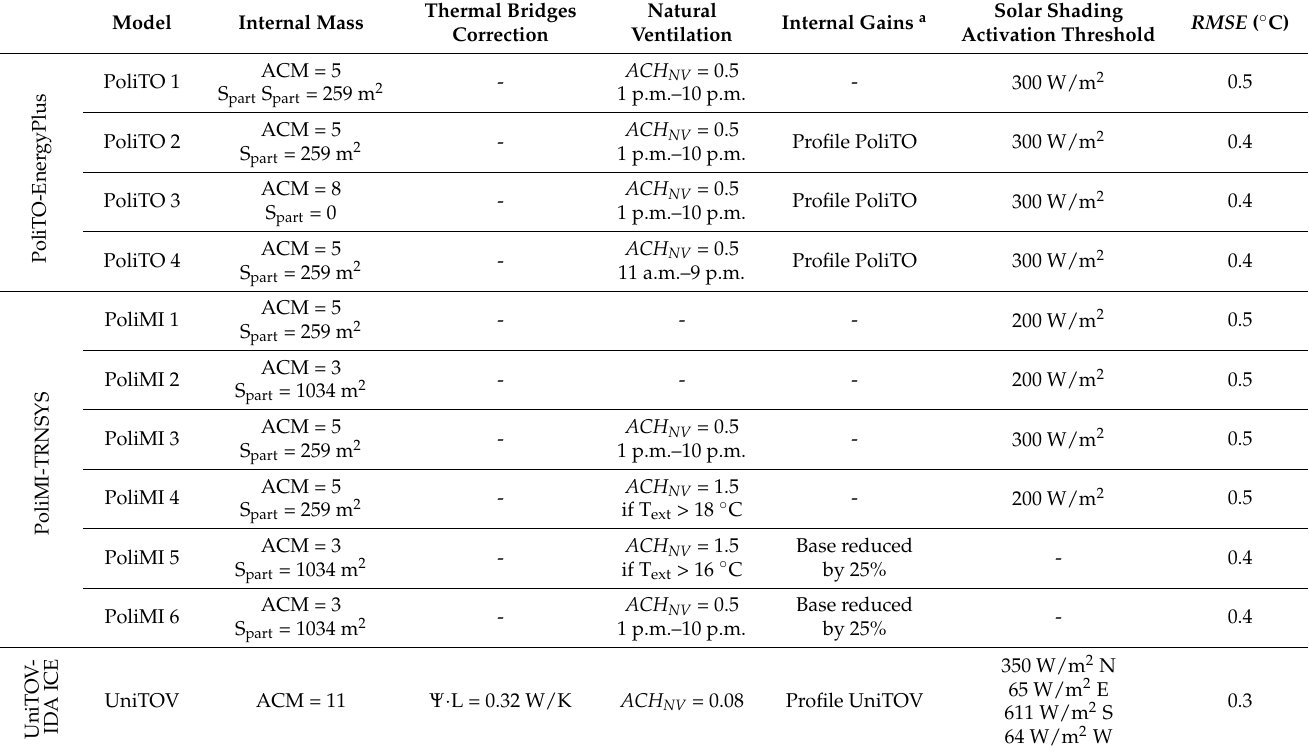
Figure 5. Maximum sensitivity of the PoliMI-TRNSYS model to the main parameters. Table 6. Calibrated models by PoliTO, PoliMI, and